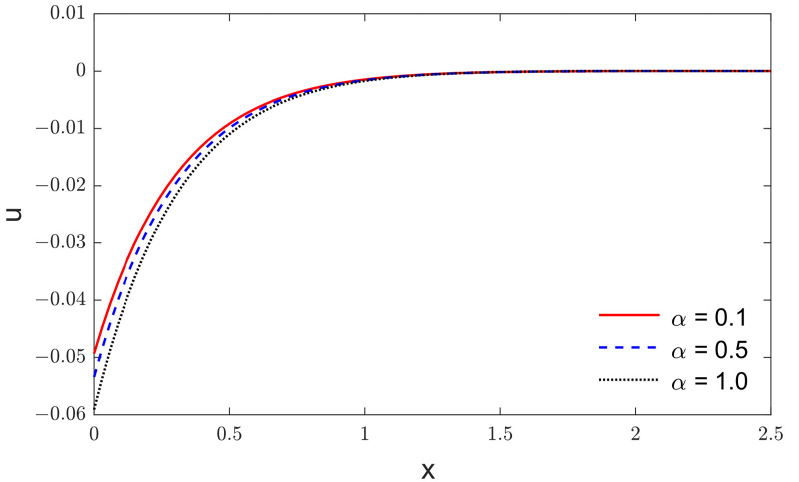
Figure 5. The impact of fractional parameter in the displacement variations along the distance 𝑥 when 𝛽 = 0.3 and 𝜏 (cid:3042) = 0.05 .